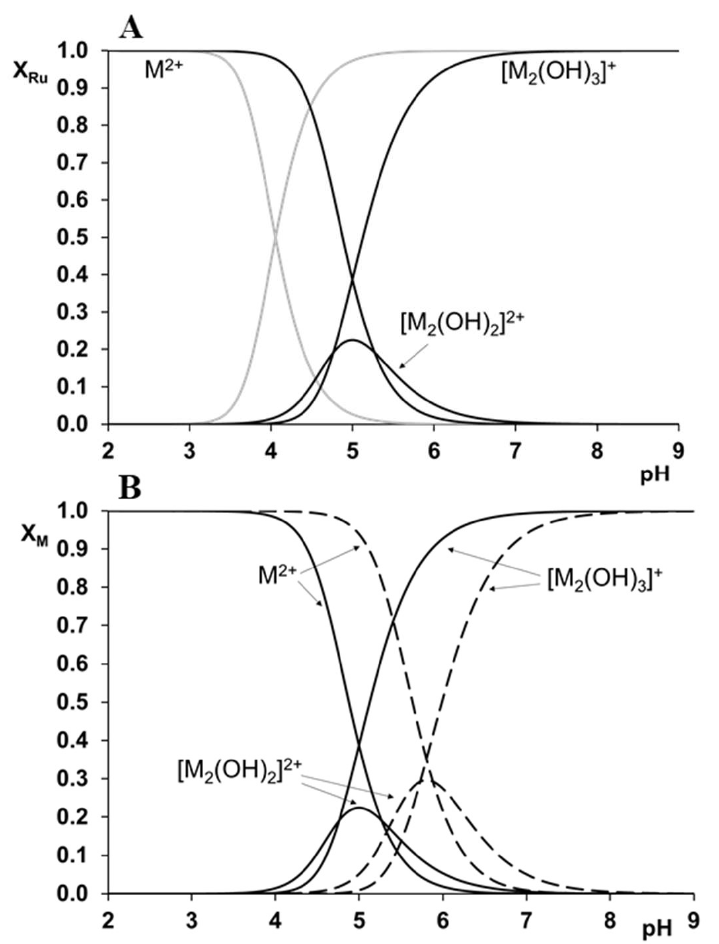
Figure 3. Concentration distribution curves calculated for ( A ) [( η 6 - p -cym)Ru(H 2 O) 3 ] 2+ at I = 0.20 M KNO 3 (grey) and at 0.20 M KCl (black) and ( B ) [( η 6 - p -cym)Ru(H 2 O) 3 ] 2+ at I = 0.20 M KCl (continuous lines) and [( η 5 -Cp*)Rh(H 2 O) 3 ] 2+ at I = 0.20 M KNO 3 (dashed lines). (M stands for [( η 6 - p -cym)Ru] 2+ or [( η 5 -Cp*)Rh] 2+ , t = 25.0 ◦ C, c M = 1 mM)].